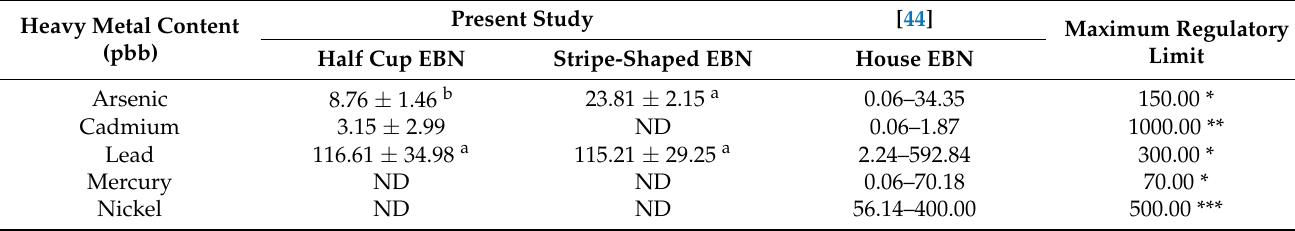
Table 5. Heavy metal content of the half cup and stripe-shaped